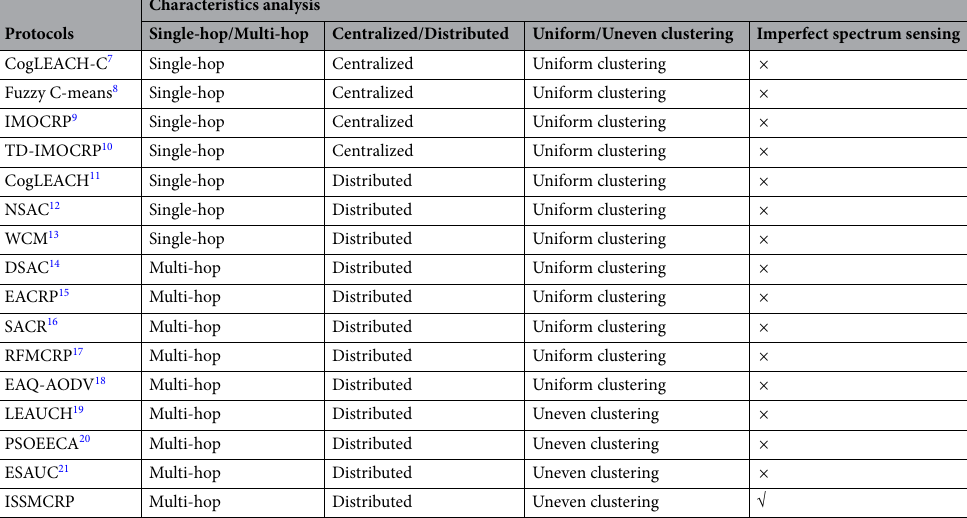
Table 1. Characteristics analysis and comparison of the existing clustering routing protocols for CRSNs.